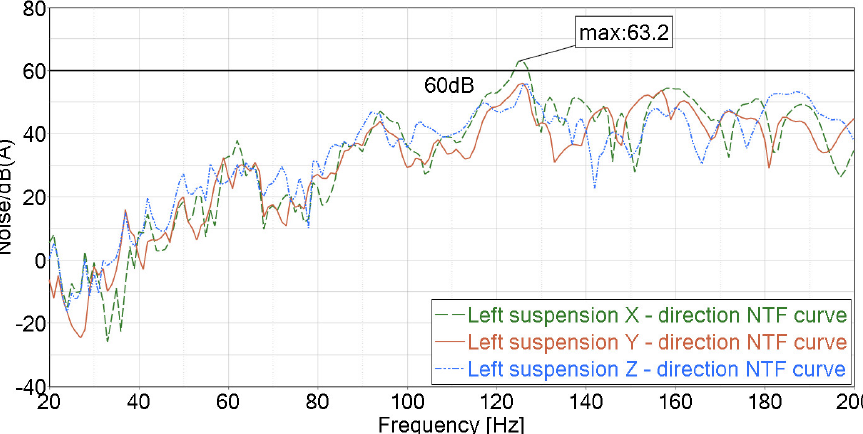
Figure 8. Left engine suspension noise transfer function curve.